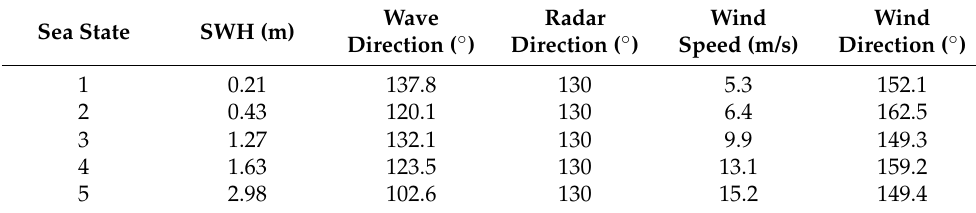
Table 4. The sea state parameters of the measured